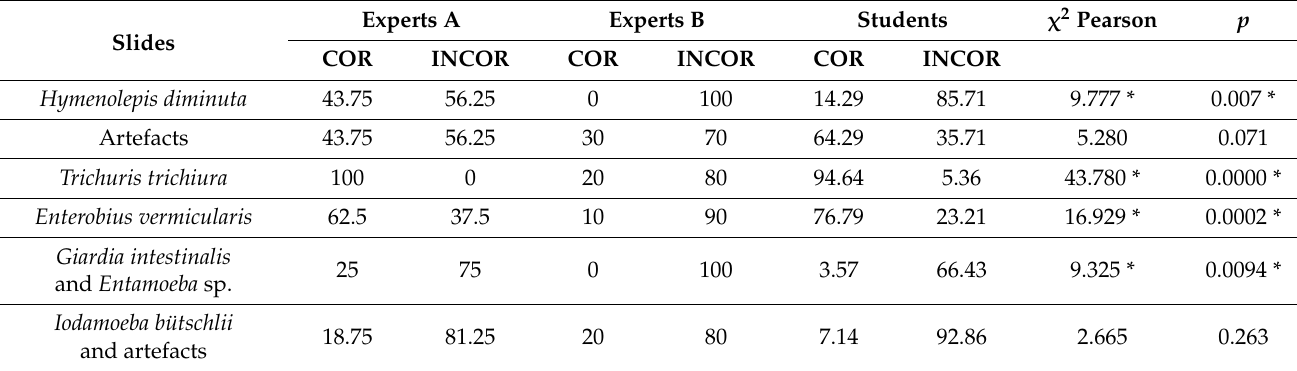
Table 1. Significance of the differences between the number of correct/incorrect parasitological diagnoses (the χ 2 Pearson test was used to compare the distribution of the answers given by the study